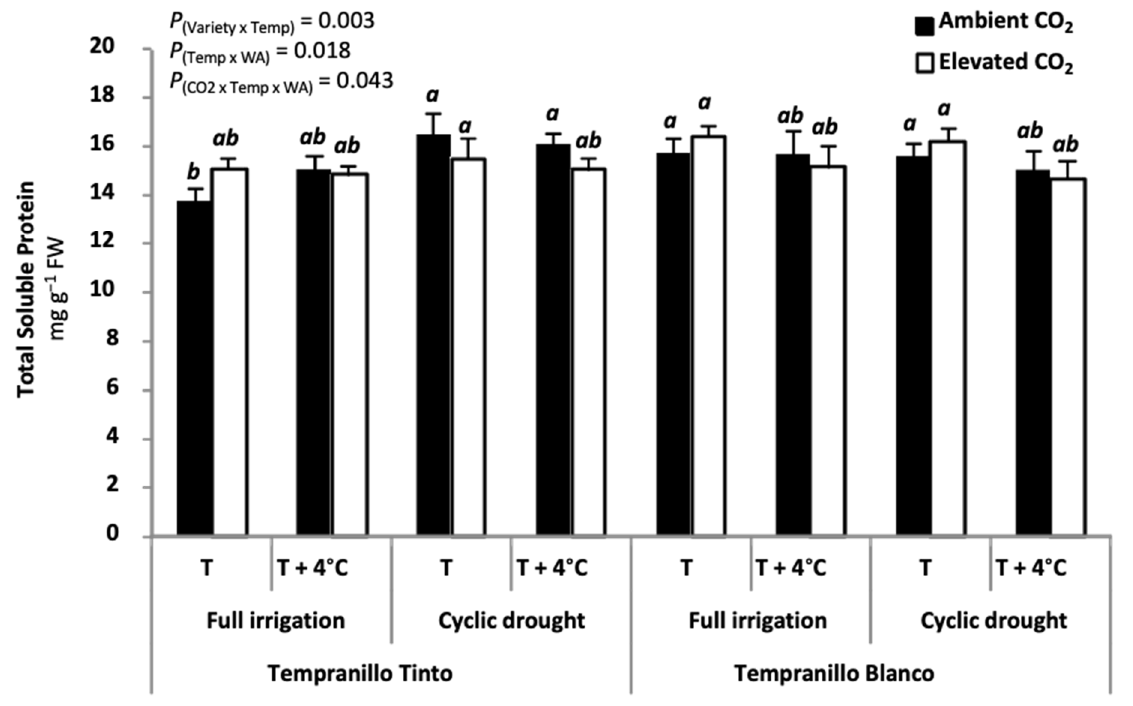
Figure 4. Total soluble protein (mg g − 1 FW) at maturity in Tempranillo Blanco and Tinto grapevine. Treatments used for growing the plants were as follows: ambient CO 2 concentration (400 ppm) versus elevated (700 ppm), ambient temperature (T) versus ambient + 4 °C (T + 4 °C), and full irrigation versus cyclic drought. Significant differences ( p < 0.05) were based on LSD test (n = 5, mean ± SE) and are indicated by different letters. Total soluble proteins data were obtained by T. Kizildeniz during her PhD thesis using the method of Bradford